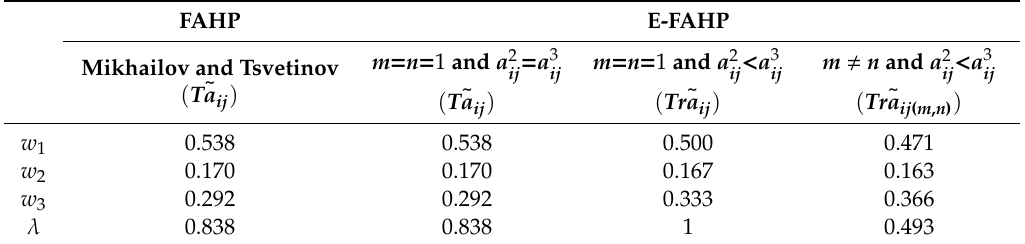
Table 6. Results from Mikhailov and Tsvetinov and E-FAHP